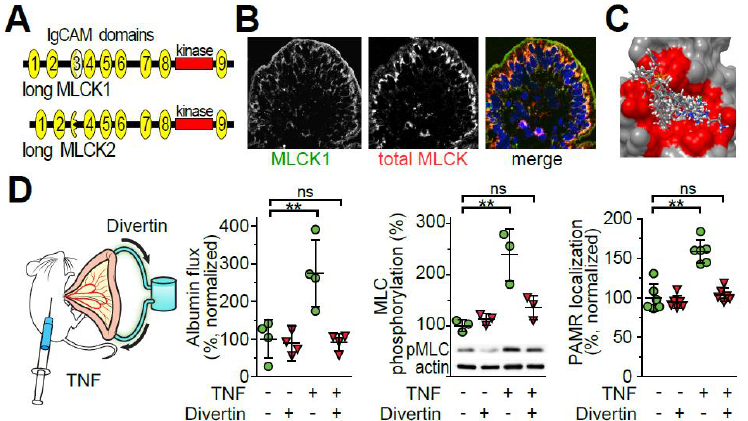
Figure 3. Specific targeting of long MLCK isoform 1 (MLCK1) prevents TNF-induced barrier loss in vivo. ( A ) Protein domain structure of long MLCK isoforms 1 and 2. Immunoglobulin-cell adhesion molecule (IgCAM) domains are numbered from the amino terminus. ( B ) Long MLCK1 (green), total MLCK (red), and nuclei (blue) in normal human jejunum. MLCK1 is preferentially-localized to the perijunctional actomyosin ring. ( C ) Virtually screened compounds docked to a binding pocket within the unique IgCAM3 domain of MLCK1. ( D ) Mice were injected with vehicle or TNF, and jejunal loops were perfused with either saline-containing vehicle or Divertin. TNF-induced increases in albumin flux (from bloodstream into the gut lumen) were blocked by Divertin. Divertin also blocked TNF-induced myosin II regulatory light chain (MLC) phosphorylation and MLCK1 recruitment to the PAMR. Notably, Divertin does not inhibit MLCK enzymatic activity. ** p < 0.01 by ANOVA with Dunn’s multiple comparison test. From Graham et al. Nat. Med.